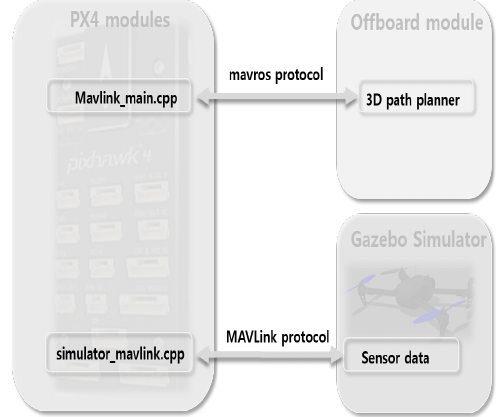
Figure 8. Software_In_The_Loop infrastructure.